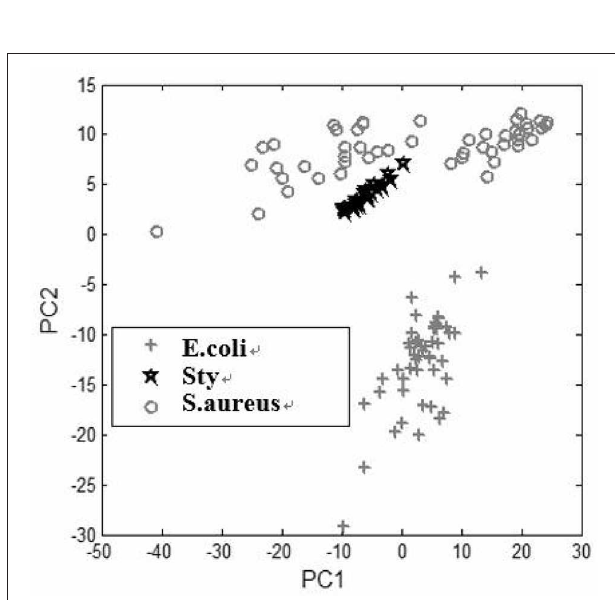
FIGURE 5 | Discrimination of the spectra of the three kinds of bacteria under alkaline condition by PCA.